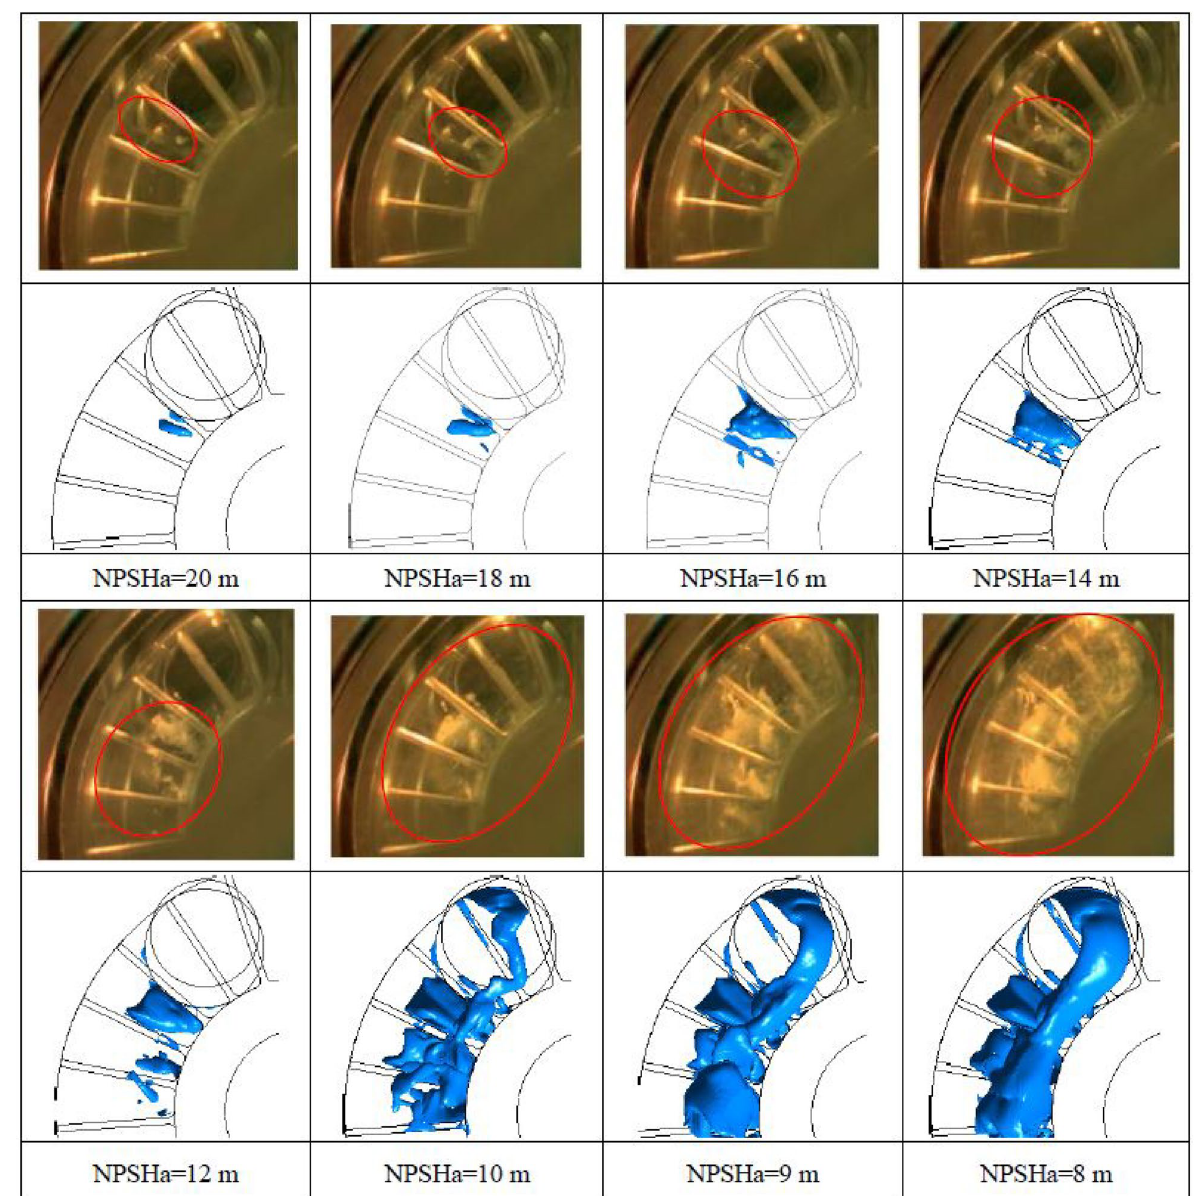
Figure 4 Comparisons of experimental photographs [26] and numerical cavity